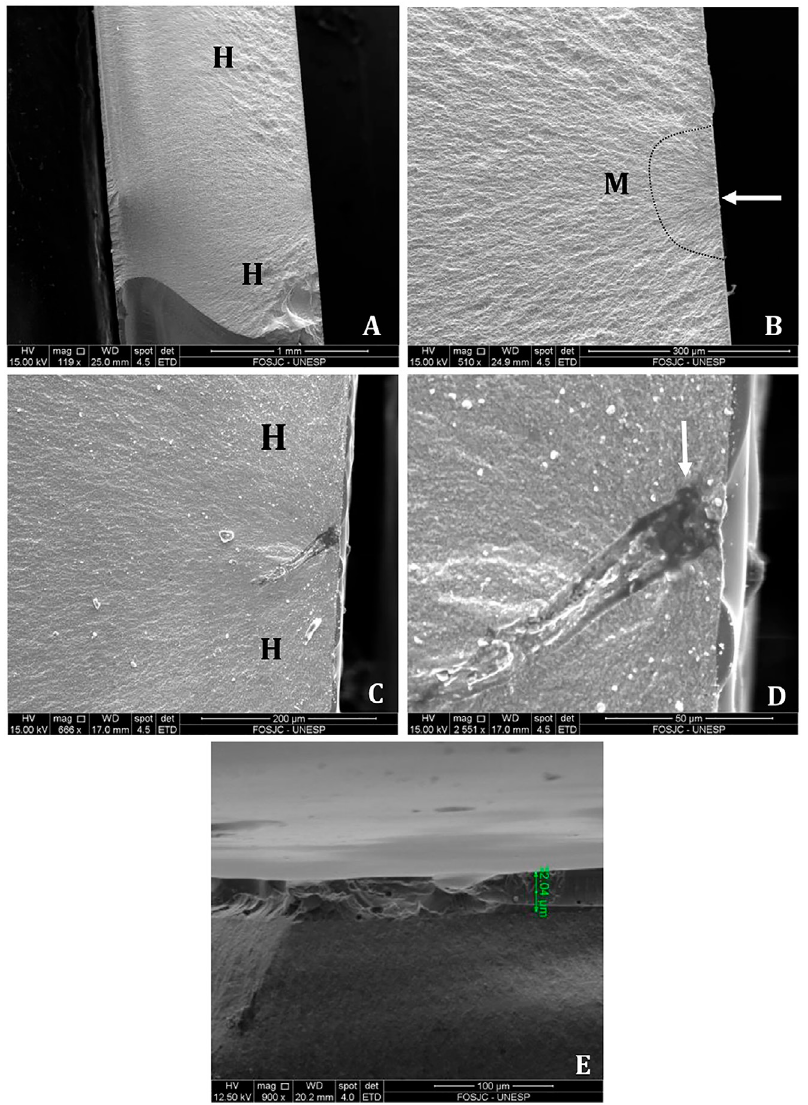
Figure 3- SEM images of fractured disc-shaped ceramic specimens following biaxial flexure strength test. All surfaces seem to present a fracture origin irradiating from the bottom (tensile) zirconia surface (the arrows indicate the failure origin site). The fracture origins of glazed on tensile side (GT) group (119×) (A). H and M are fracture marks that stand for Hackles and Mirror, delimited by the curved line (510×) (B). Failure originated from the surface, close to an internal defect of glaze on tensile and compression side (GTC) group (666×) (C). Close image of internal defect of GTC group (2,551×) magnification (D). Glazed compression side of group GC, where pores are clearly seen, but do not seem to initiate failure (900×)